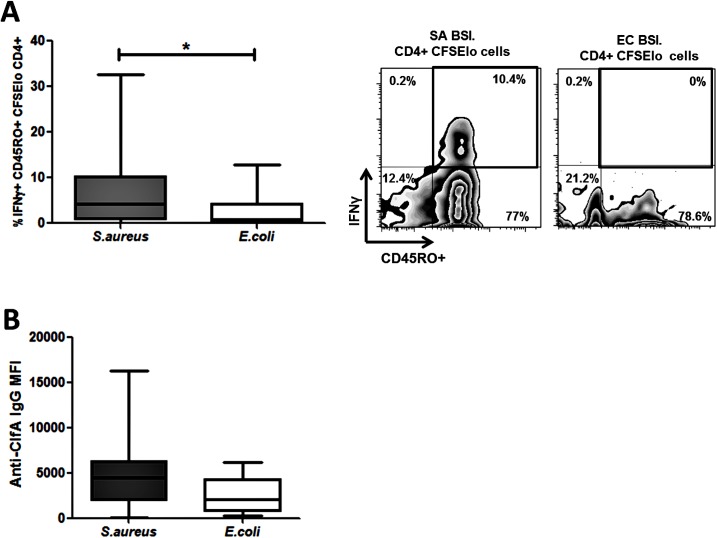
Human S. aureus bloodstream infection induces S. aureus antigen-specific effector memory Th1 cells and anti-ClfA antibodies.PBMCs were isolated from patients, CFSE-labelled and incubated with heat-killed S. aureus PS80 strain (1μg/ml ≈ 1x107 CFU/ml) or media alone for 10 d. Proportions of S. aureus antigen-specific effector memory cells were assessed by gating on IFNγ+CD45RO+ cells in the CFSElo CD4+ population (A). For each patient, media only responses were subtracted from responses to heat-killed S. aureus to determine the antigen-specific response. n = 5–12 per group. IgG antibody binding to ClfA was measured in patient sera using a bead-based flow cytometry technique (B). n = 11–24 per group. Results shown as box-and-whiskers plots where the horizontal line indicates the median, boundaries of the box the IQR, and whiskers indicate the highest and lowest values of the results, and representative FACS plots of CD4+CFSElo cells (A). SA = S. aureus, EC = E. coli, BSI = bloodstream infection. * p<0.05.